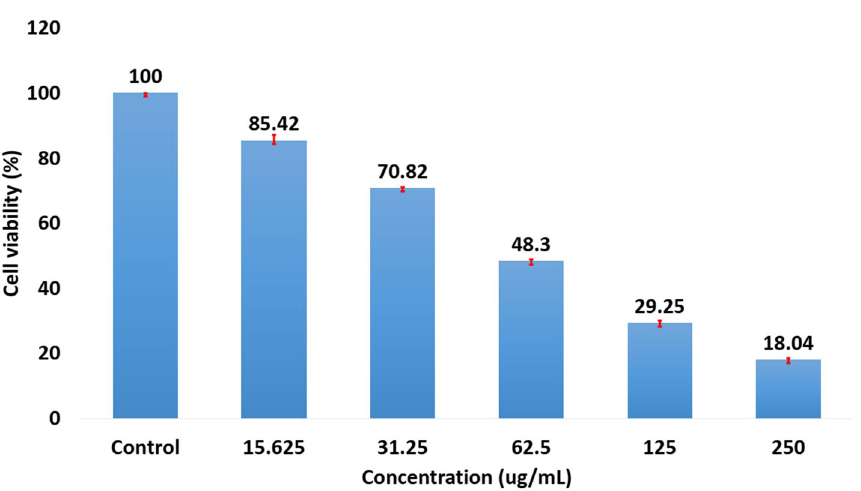
Figure 12. The graph showing decrease in cell viability of Human Lung Adenocarcinoma cells while increasing the concentration of the test sample (Exopolysaccharide isolated from the diatom Nitzschia palea